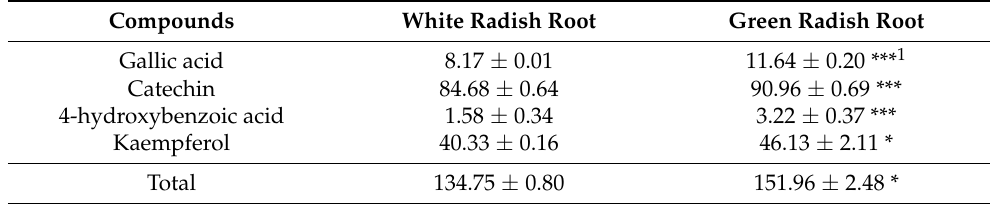
Table 2. Phenolic content in white and green radish cultivars ( µ g g − 1 ). Compounds